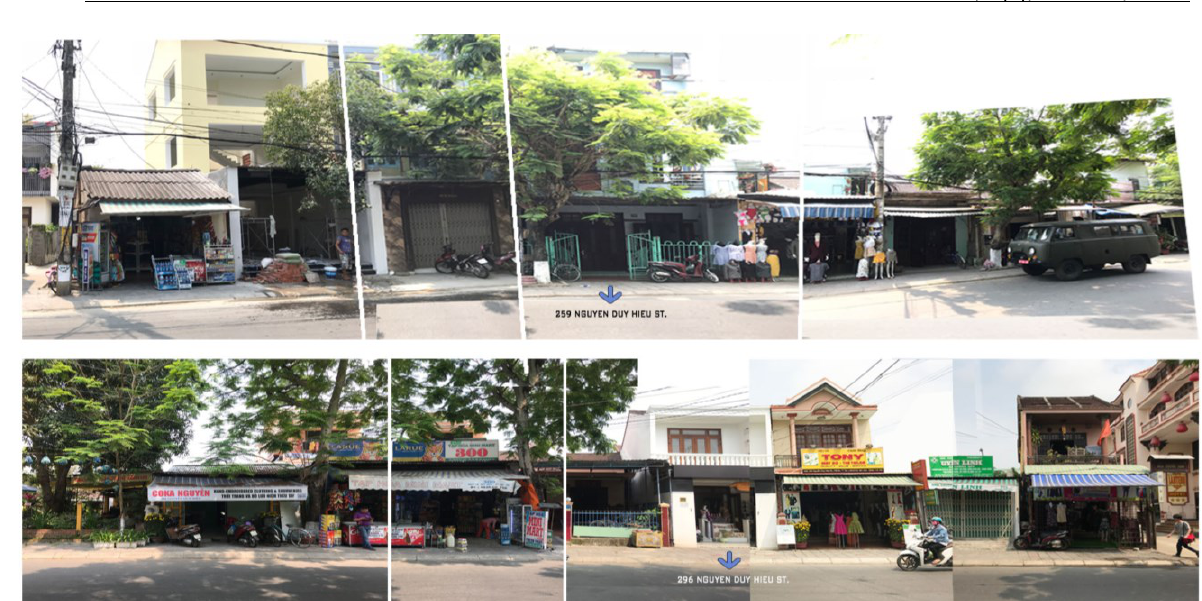
Figure 5. Street facade around House C (259 Ng. Duy Hieu St.) and House D (296 Ng. Duy Hieu St.)